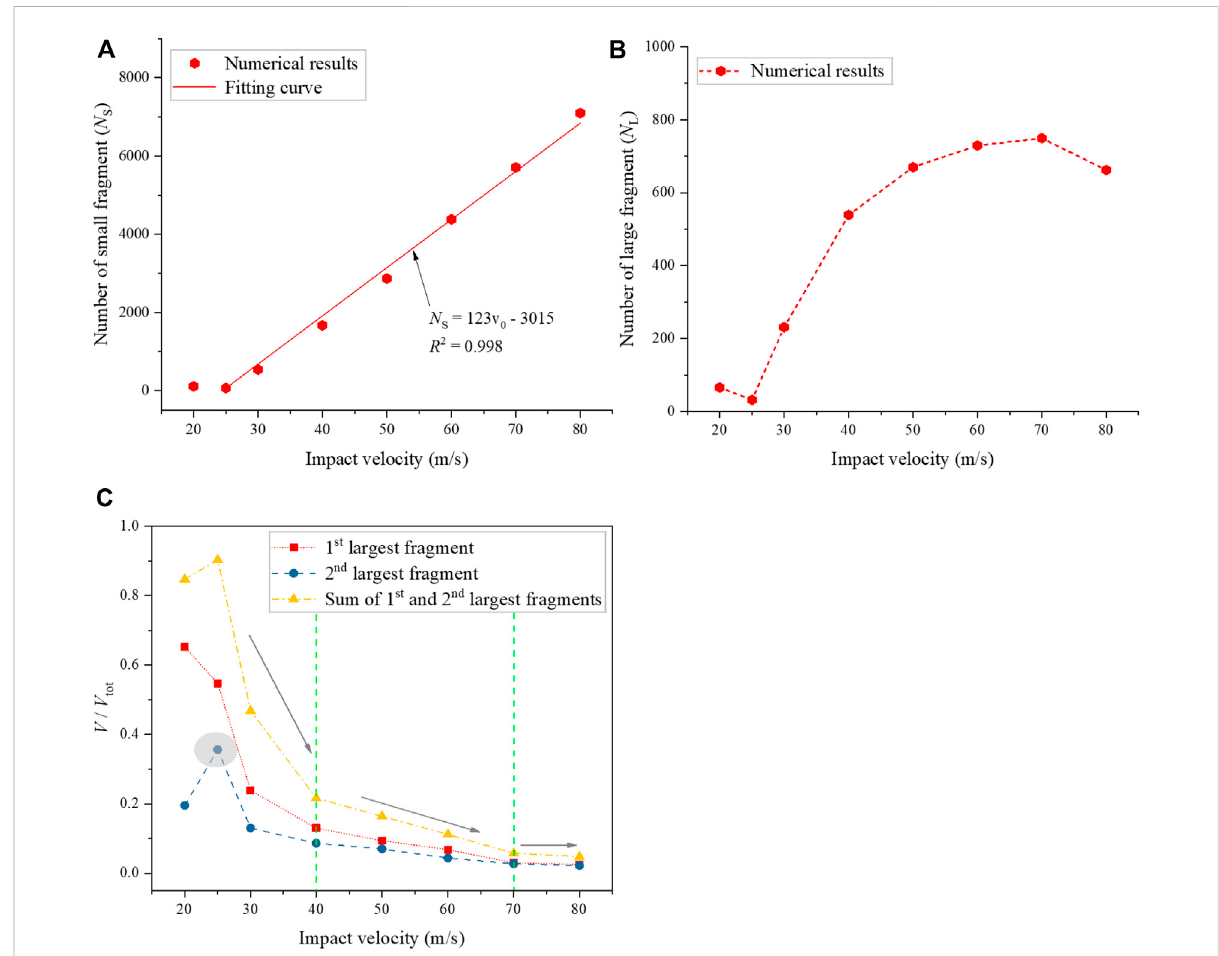
FIGURE 11 Fragmentationcharacteristicsofthesampleunderdifferentimpactvelocities; (A) thenumberofthesmallfragment; (B) thenumberofthelarge fragment; (C) variation in the sizes of the two largest fragments and their sum versus the impact velocity (the oval shaded area shows the mutation point, the green vertical dashed lines and gray arrow show three different variation rate